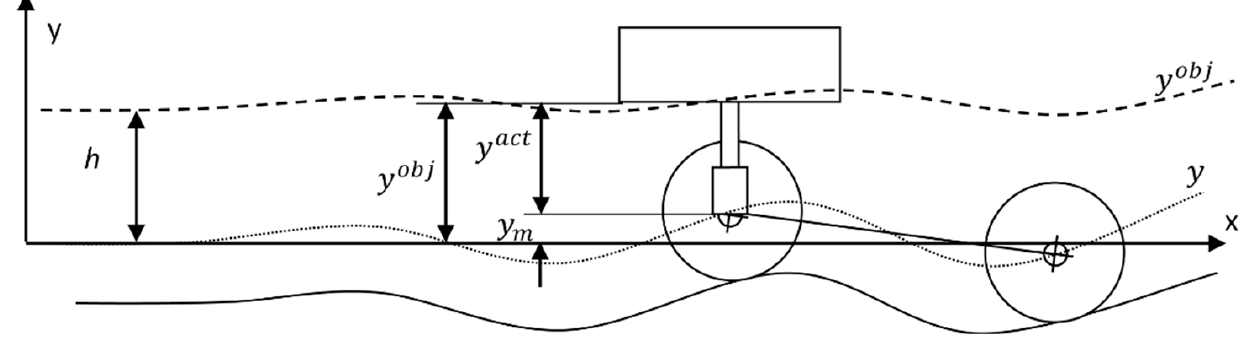
Figure 6. Heights that are involved in the calculus of the actuated distance.